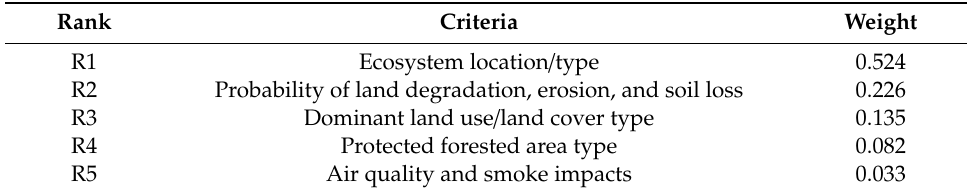
Table A8. Pair-wise comparison reciprocal matrix for the e ff ects on landscape and vegetation fire e ff ects category. RCI: random consistency index; CI: consistency index; CR: consistency ratio; λ max : principal